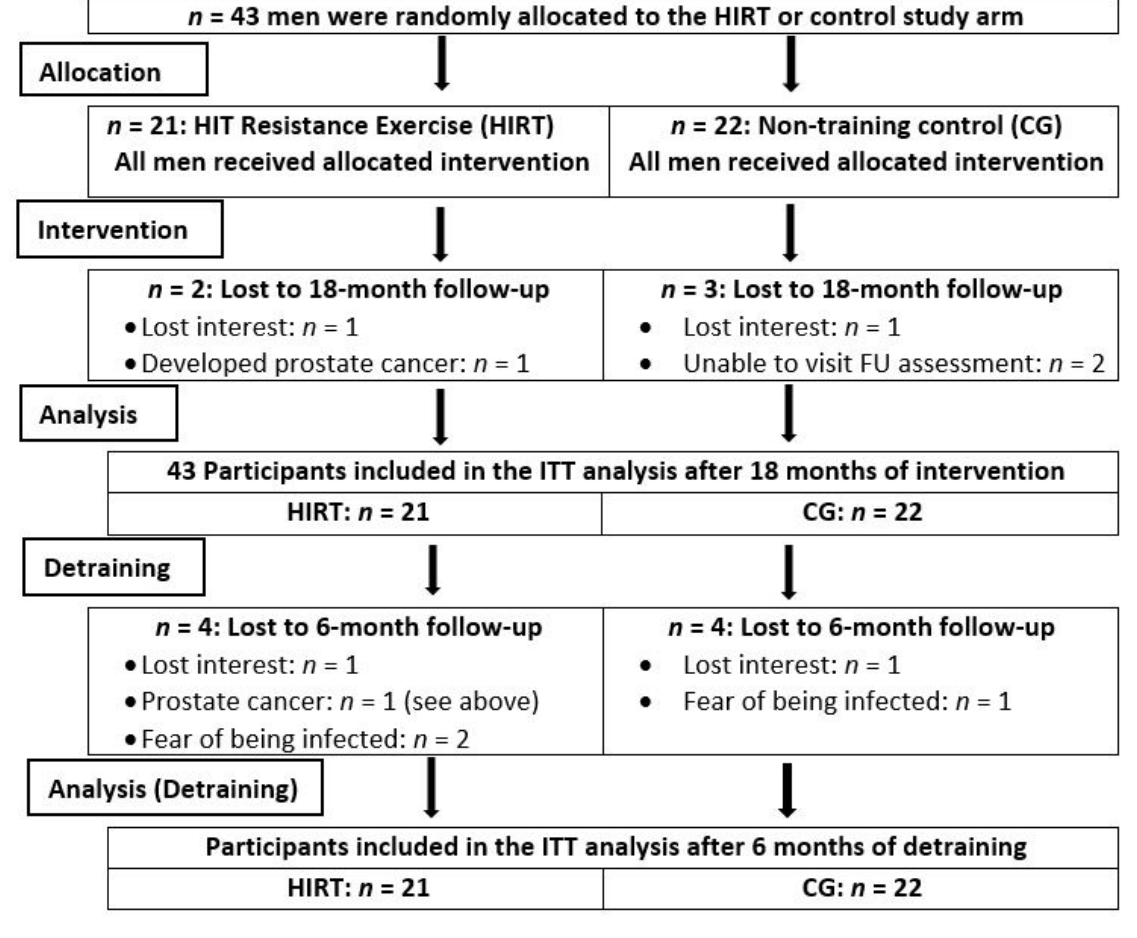
Figure 1. Flowchart of the FrOST study. CG, control group; HIRT, high-intensity resistance exercise training.